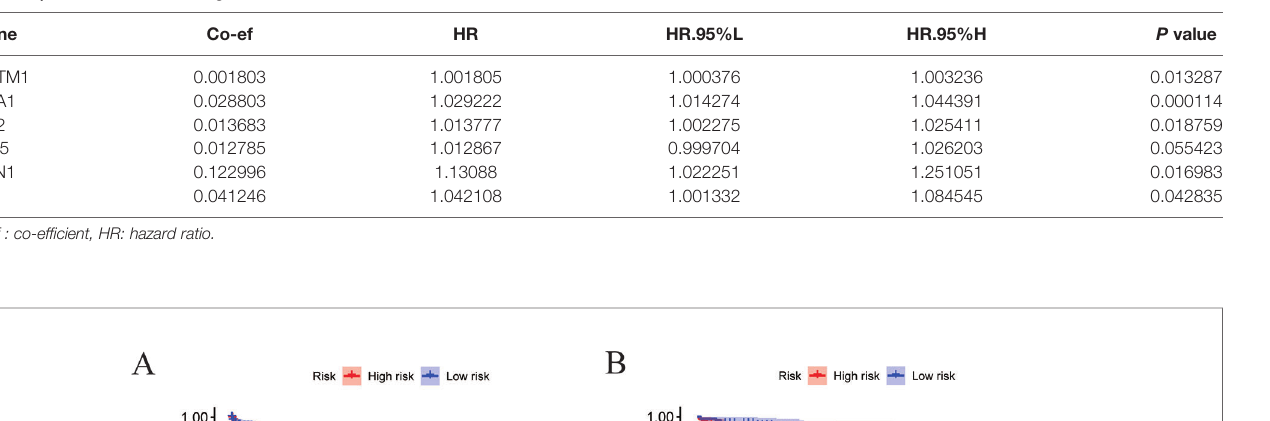
TABLE 3 | Parameters for building multivariate COX